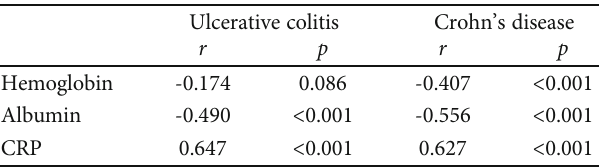
Figure 2: Comparison of the serum leucine-rich alpha-2 glycoprotein (LRG) levels between active and inactive disease, according to the involved area in patients with ulcerative colitis (a) and Crohn ’ s disease (b). The bars indicate the median ± 25 th percentile. The lower bar indicates the 10 th percentile, and the upper bar indicates the 90 th percentile. I: inactive; A: active; n.s.: not signi fi cant. Table 2: Correlation coe ffi cients and signi fi cance of di ff erences in the levels of serum LRG and laboratory parameters between patients with ulcerative colitis and Crohn ’ s